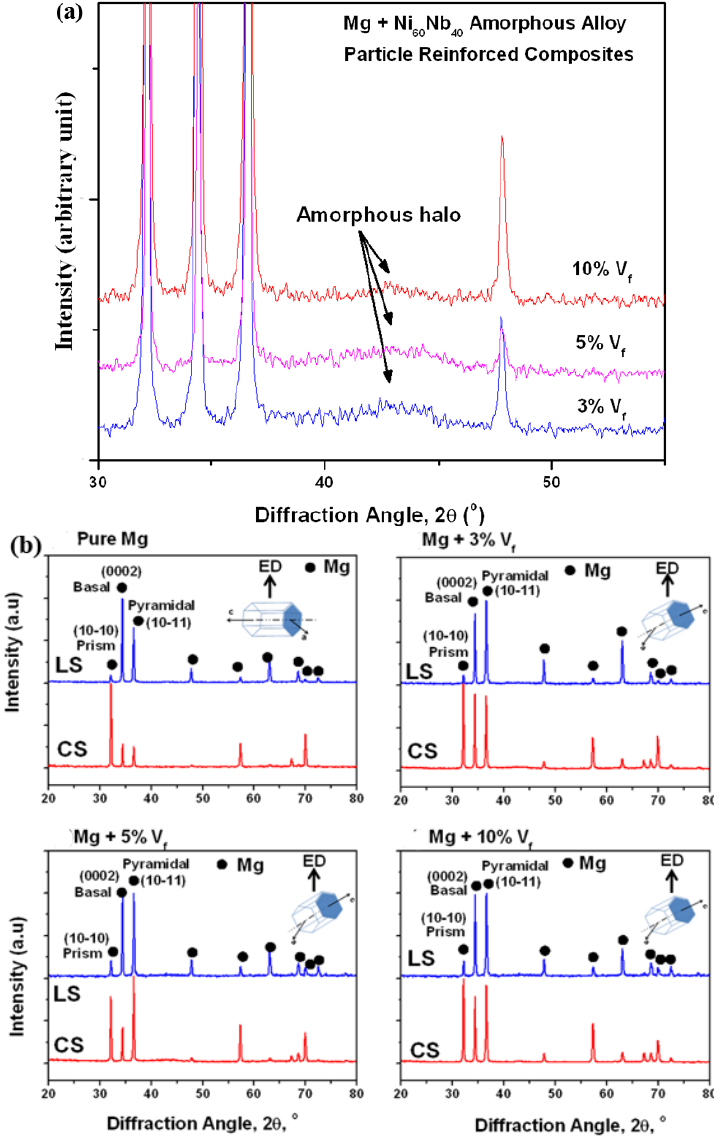
Figure 14. ( a ) XRD diffractograms of Mg-Ni 60 Nb 40 composites showing the retention of amorphous structure at all volume fractions and ( b ) change in crystal orientation due to amorphous reinforcement addition. (reprinted from Jayalakshmi et al . 2014 [16], with permission from ©